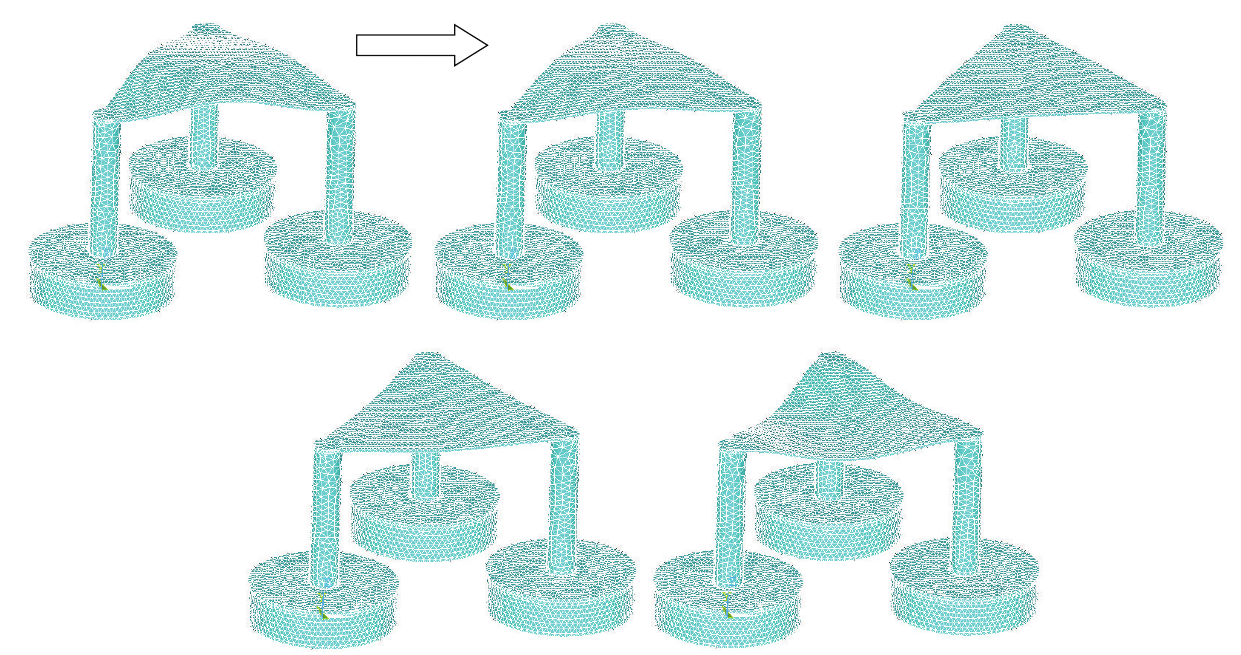
Figure 15: Third modal